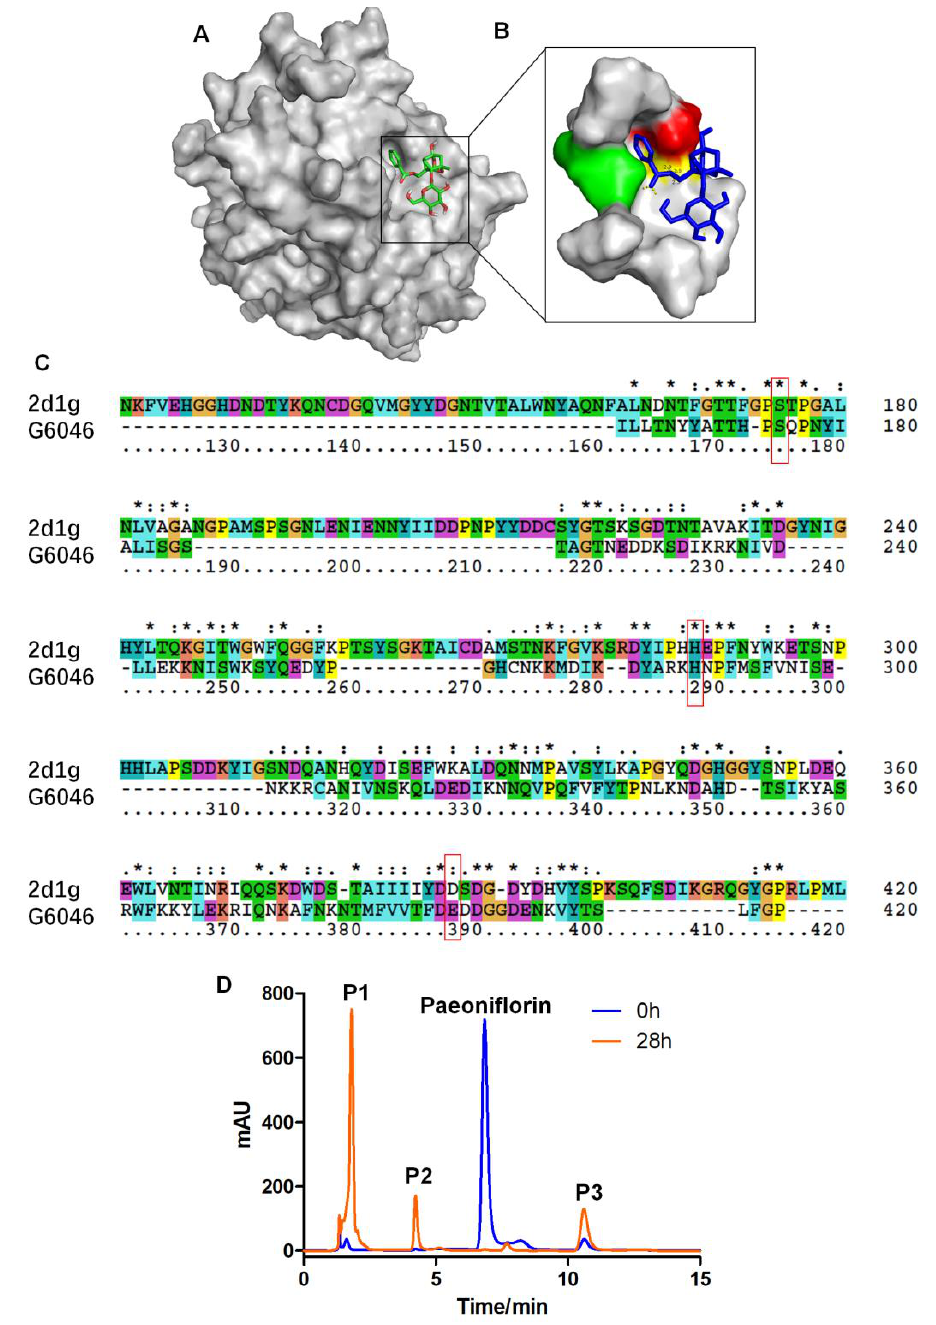
Figure 6. Transformation of paeoniflorin to P1, P2, and P3 mediated by G6046. ( A ) Molecule docking between G6046 and paeoniflorin produced using PSIPRED 4.0 and Phyre2; ( B ) surface topography of the active site entrance, Ser-87 is in red, His-150 is in green, and Glu-235 is in yellow; ( C ) sequence alignment of ApcA 2d1g and G6046 Ser-87, His-150, and Glu-235 in G6046 corresponding to Ser- 175, His-288, and Asp-388 in ApcA 2d1g are indicated in the red boxes; ( D ) HPLC analysis of the conversion activity of G6046, obtained on an Agilent ZORBAX SB-C18 (4.6 × 250 mm, 5μm); column temperature, 30 °C; mobile phase, H 2 O (0.2% phosphoric acid):methanol = 70:30 ( v / v ); flow rate, 1.0 mL/min; injection volume, 10 μL; detection wavelength, 230 nm. After 28 h of reaction, the main conversion products were labelled P1, P2, and P3. * indicates positions which have a single, fully conserved residue, : indicates that one of the following “strong” groups is fully conserved.